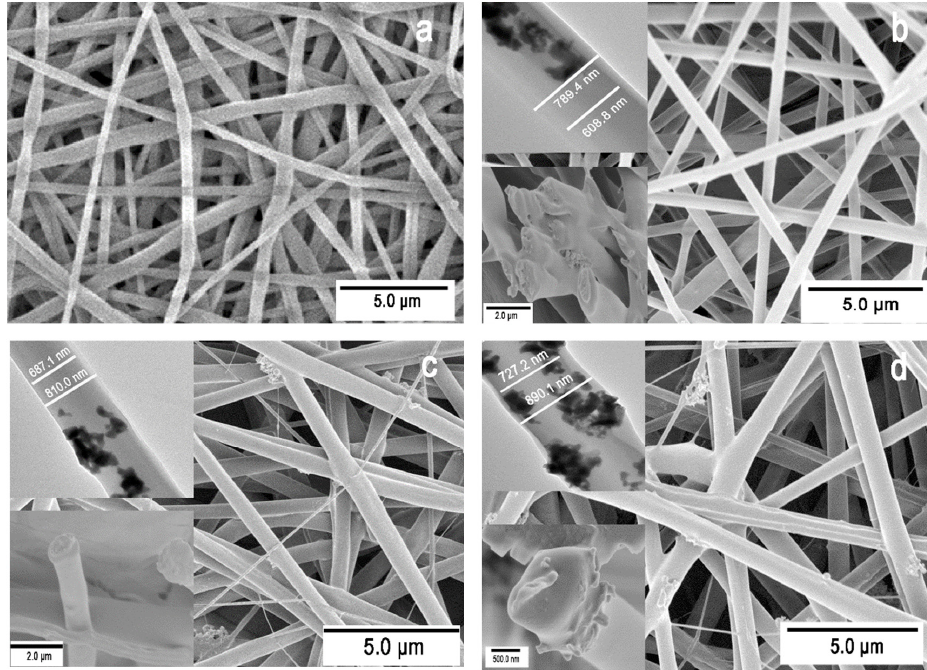
Figure 2. ( a ) SEM image of cellulose/PVDF ‐ HFP nanofibers; ( b ) composite nanofibers containing 2% LLTO; ( c ) 5% LLTO and ( d ) 8% LLTO; inset images are TEM and SEM images of cross ‐